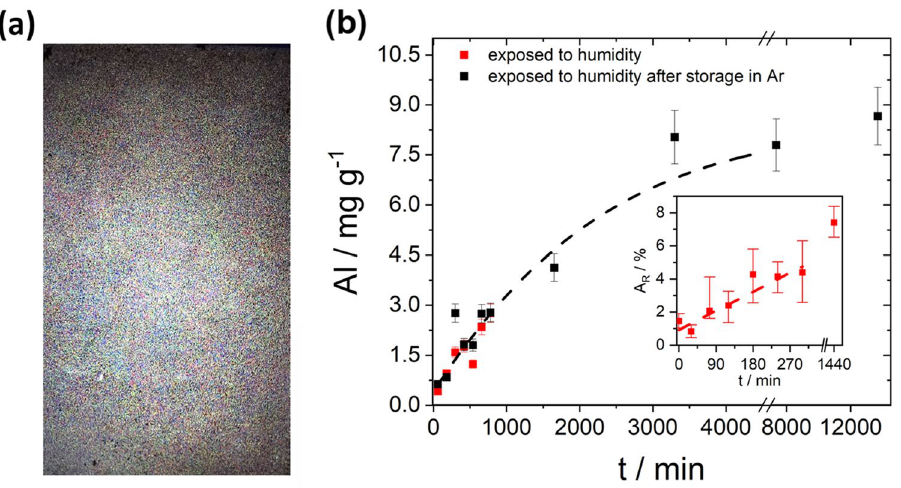
Figure 3. ( a ) after 24 h in air stored, decoated carrier foil (transilluminated); ( b ) Aluminum content of the cathode material as a function of exposure time at φ ≈ 55%, Inset: relative area of the holes of the foils during storage at ambient air humidity of φ ≈ 55% as a function of time; the dashed lines are